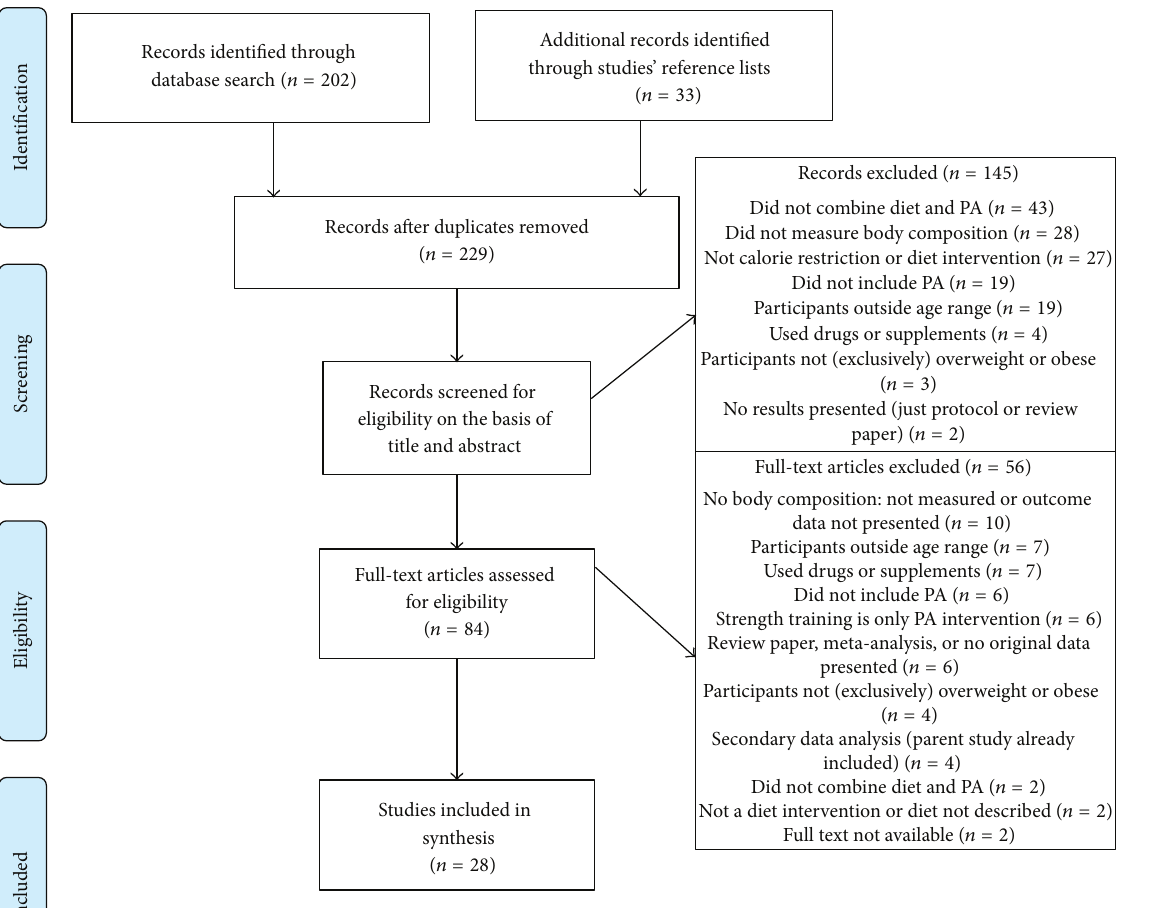
Figure 1: PRISMA flow diagram of article screening and